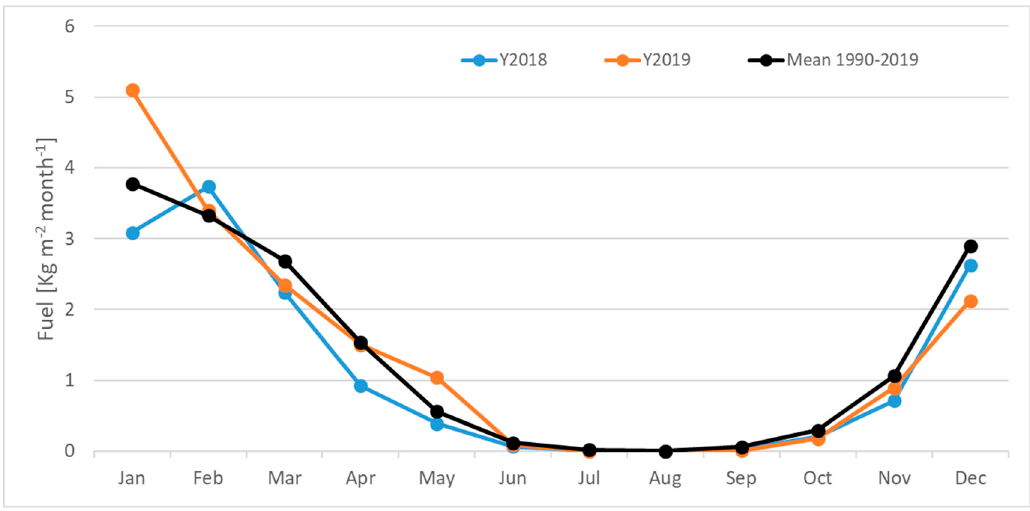
Figure 5. Fuel consumption on month basis of 2018, 2019, and the average from 1990 to 2019.